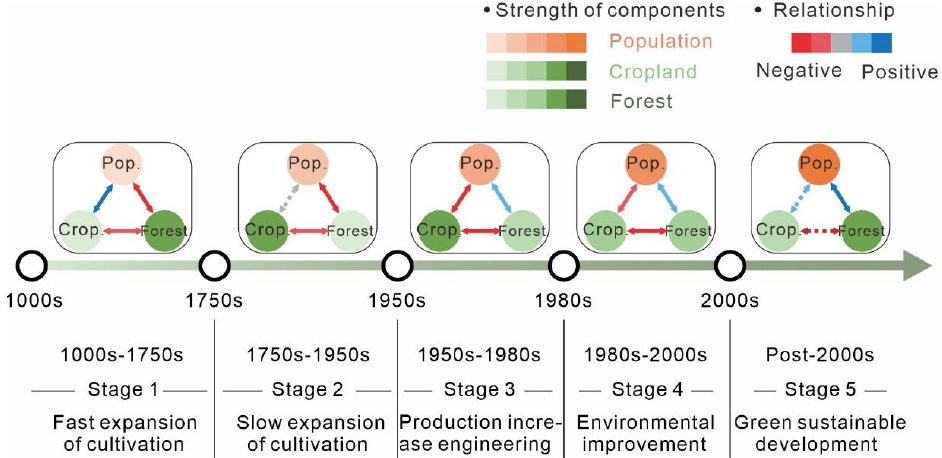
Figure 3. Evolutionary phases of the SES of Guizhou Province.